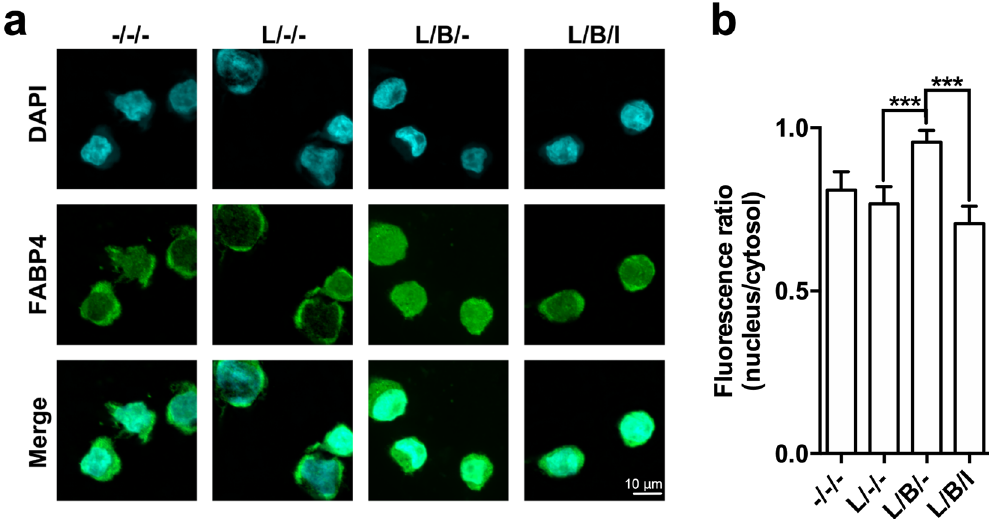
Figure 3. Effect of bindarit on the subcellular localization of FABP4 in MM-6 cells. ( a ) Indirect immunostaining of FABP4 in human monocytes. FABP4 was visualized by confocal immunofluorescence microscopy in MM-6 cells left untreated ( − / − / − ) or treated with 100 ng/mL LPS (L) for 20 hours, in the absence (L/ − / − ) or presence of 300 μ M bindarit used alone (L/B/ − ) or in combination with 5 μ M of BMS309403 (L/B/I). After each treatment, cells were fixed and stained with anti-FABP4 (green, middle panel) and with DAPI for nuclear labeling (cyan, top panels). Merged images are shown in the bottom panels. Images are representative of 2 independent experiments. ( b) Ratios of fluorescence intensity between nucleus and cytosol of 20–28 cells under each condition were calculated as described in Materials and Methods, and are reported as mean ± S.D. Significance is shown as P value calculated using an unpaired t -test. *** P <